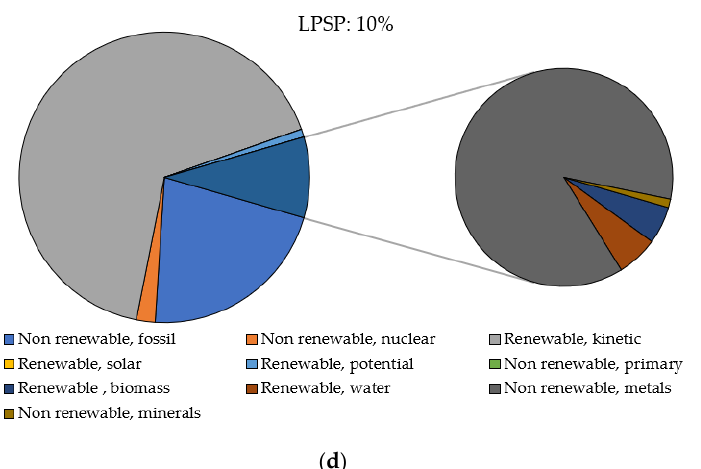
Figure 5. The contribution of impacts categories in developing the total CExD for producing 1 m 3 freshwater by SWROD/WT/BBS when the battery is full. ( a ) LPSP 0%, ( b ) LPSP 2%, ( c ) LPSP 5%, and ( d ) LPSP 10%.